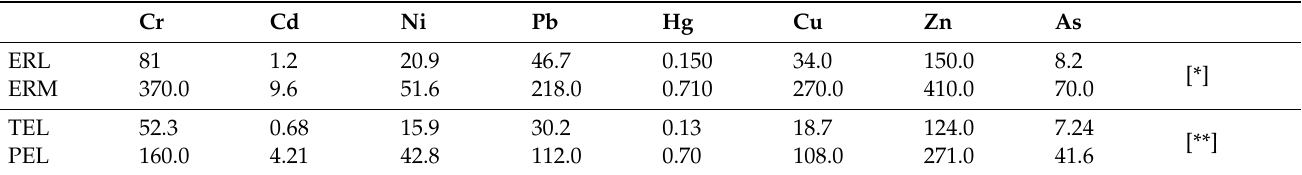
Table 1. Sediment Quality Guideline values (mg kg − 1 , dry weight). (ERL) Effects of Low Range